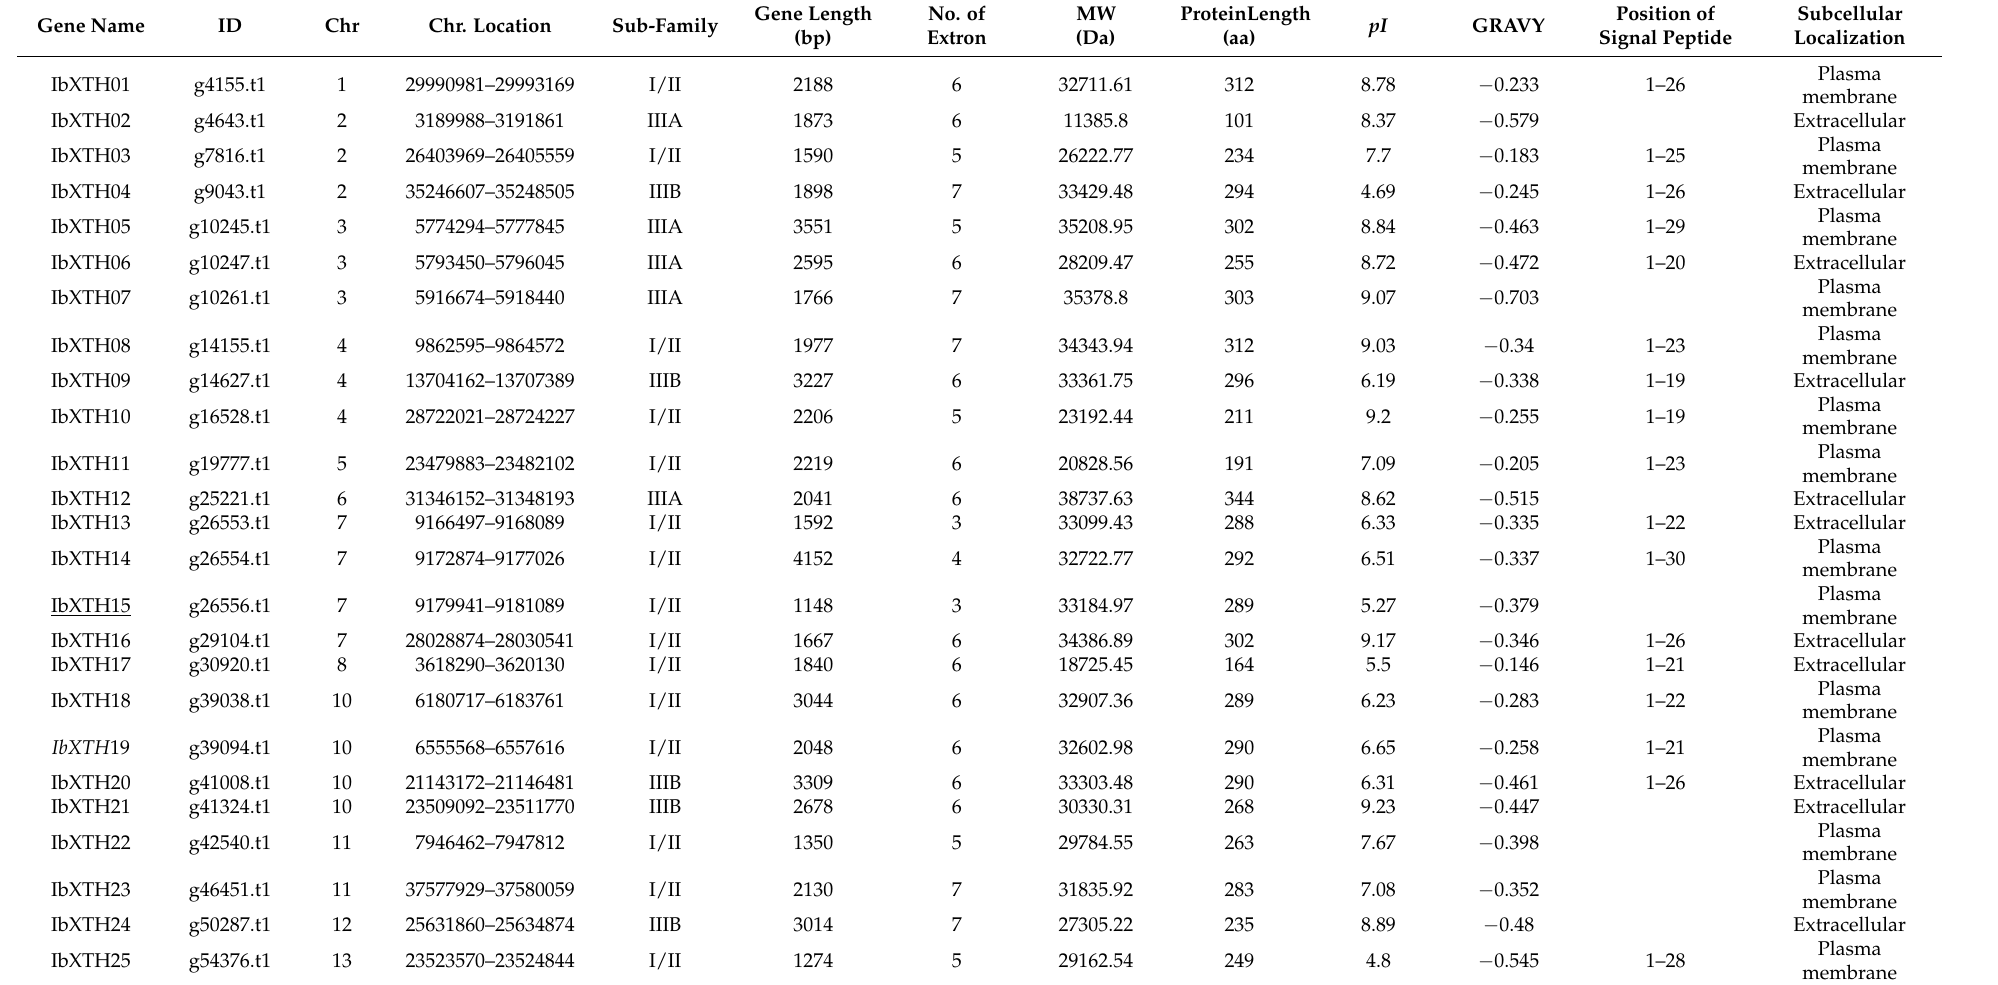
Table 1. Basic information and physicochemical properties of sweet potato XTH